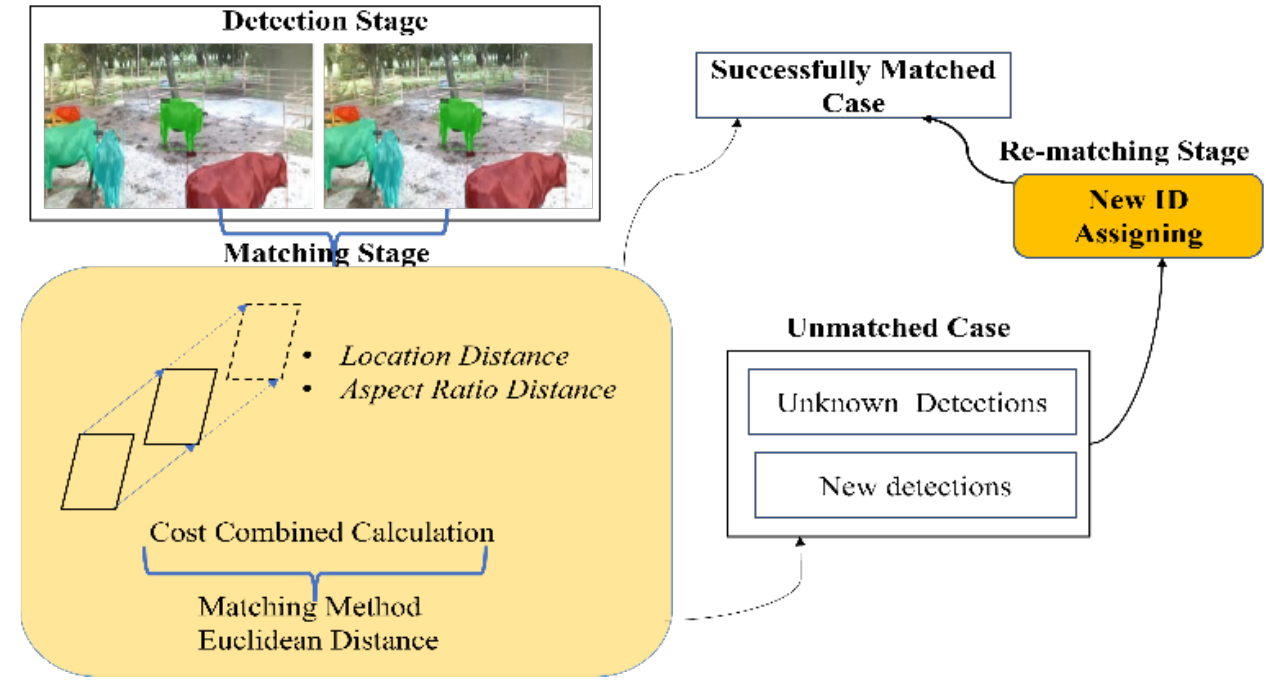
Figure 8. The proposed customized tracking algorithm .